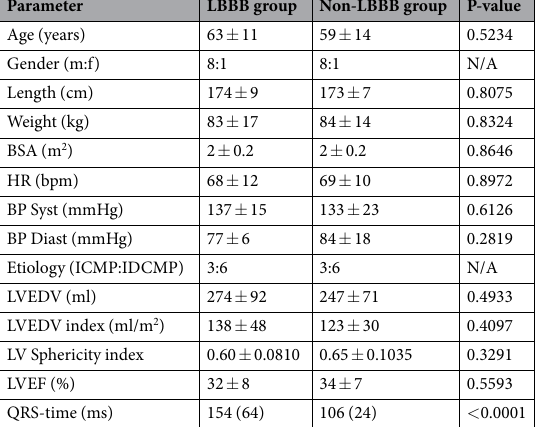
Table 1. Demographic and clinical parameters. M, male; F, female; BSA, Body Surface Area; HR, Heart Rate; BP, Blood Pressure; LV, Left Ventricle; EDV, End-diastolic Volume; EF, Ejection